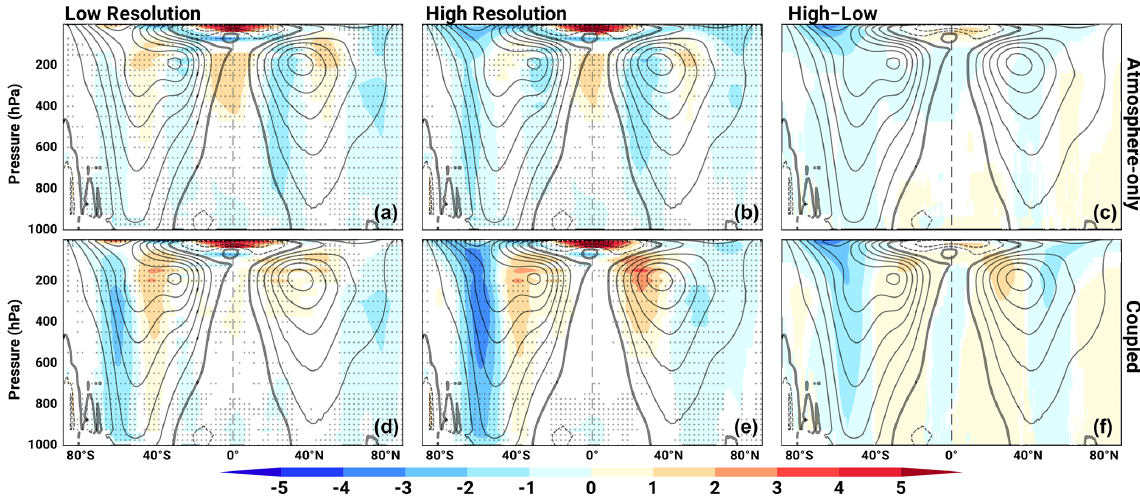
Figure 6. Multi-model ensemble mean bias in the zonally averaged zonal wind (in ms − 1 ) with respect to ERA5 at low and high resolution (a, d and b, e) and differences between the two resolutions (c, f) , as in Fig. 1. Contours represent the ERA5 climatology (every 5ms − 1 ; negative values, for easterlies, are dashed lines, and positive values, for westerlies, are solid